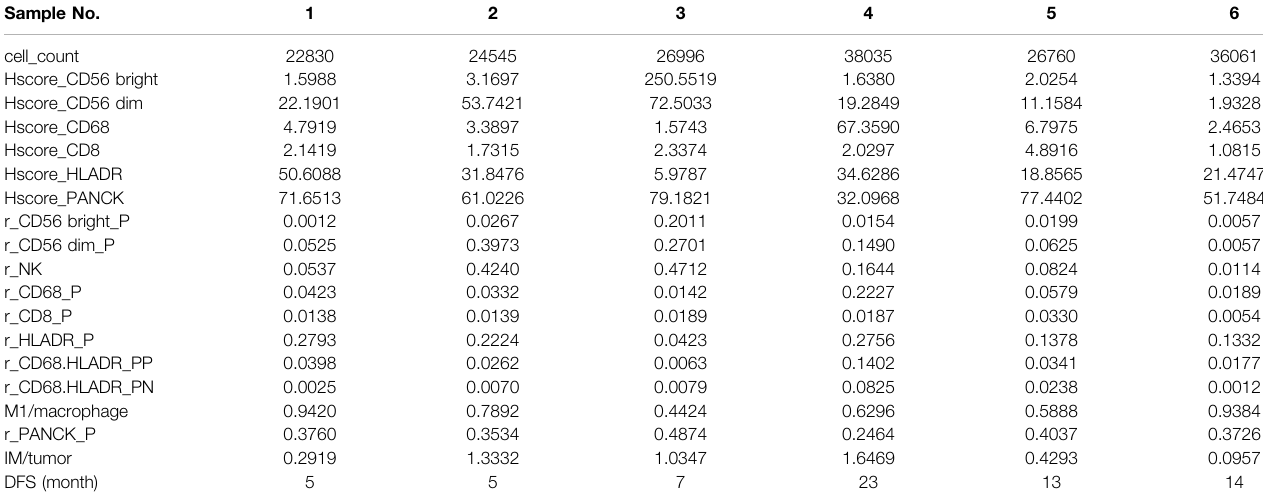
TABLE 2 | Fraction of immune and tumor cells mentioned in each sample. Sample